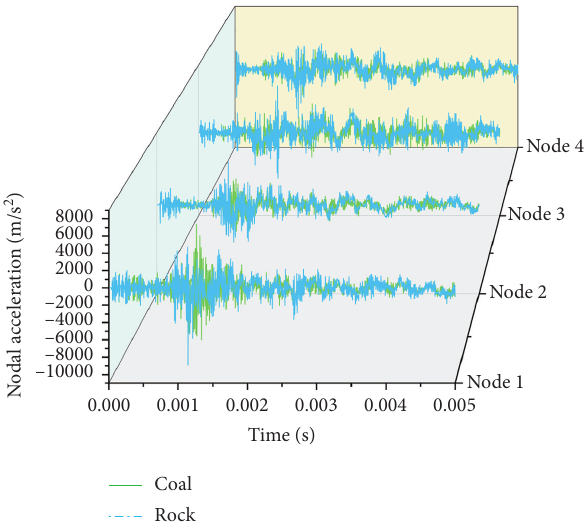
Figure 9: Nodal acceleration in the tail beam noncollision contact zone under the impact of coal-rock particles.